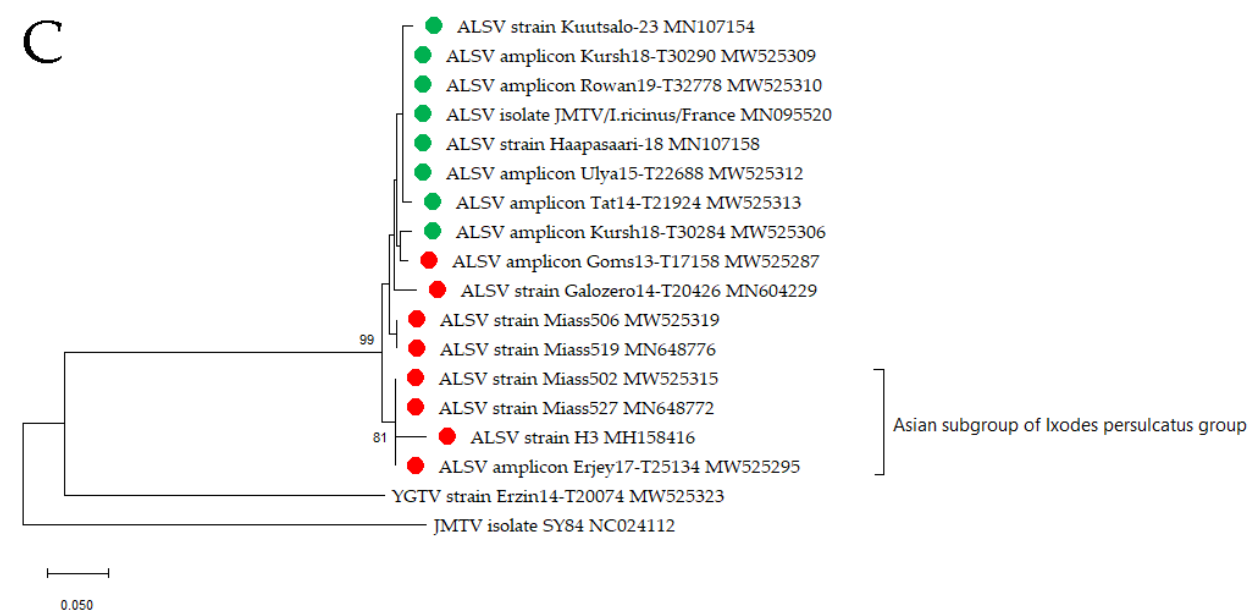
Figure 4. Phylogenetic analysis of the Alongshan virus (ALSV) proteins was performed using the neighbour-joining method in MEGA X. Descriptions of the sequences published in GenBank were reproduced without changes. Red circle— amplicons/strains from the Ixodes persulcatus group, and green circle—amplicons/strains from the Ixodes ricinus group ( A ). Complete amino acid sequence of the VP1a protein. ( B ) Complete amino acid sequence of the VP1b protein. ( C ) Complete amino acid sequence of the novel upstream open reading frame (nuORF) protein. YGTV = Yanggou tick virus and JMTV = Jingmen tick virus.